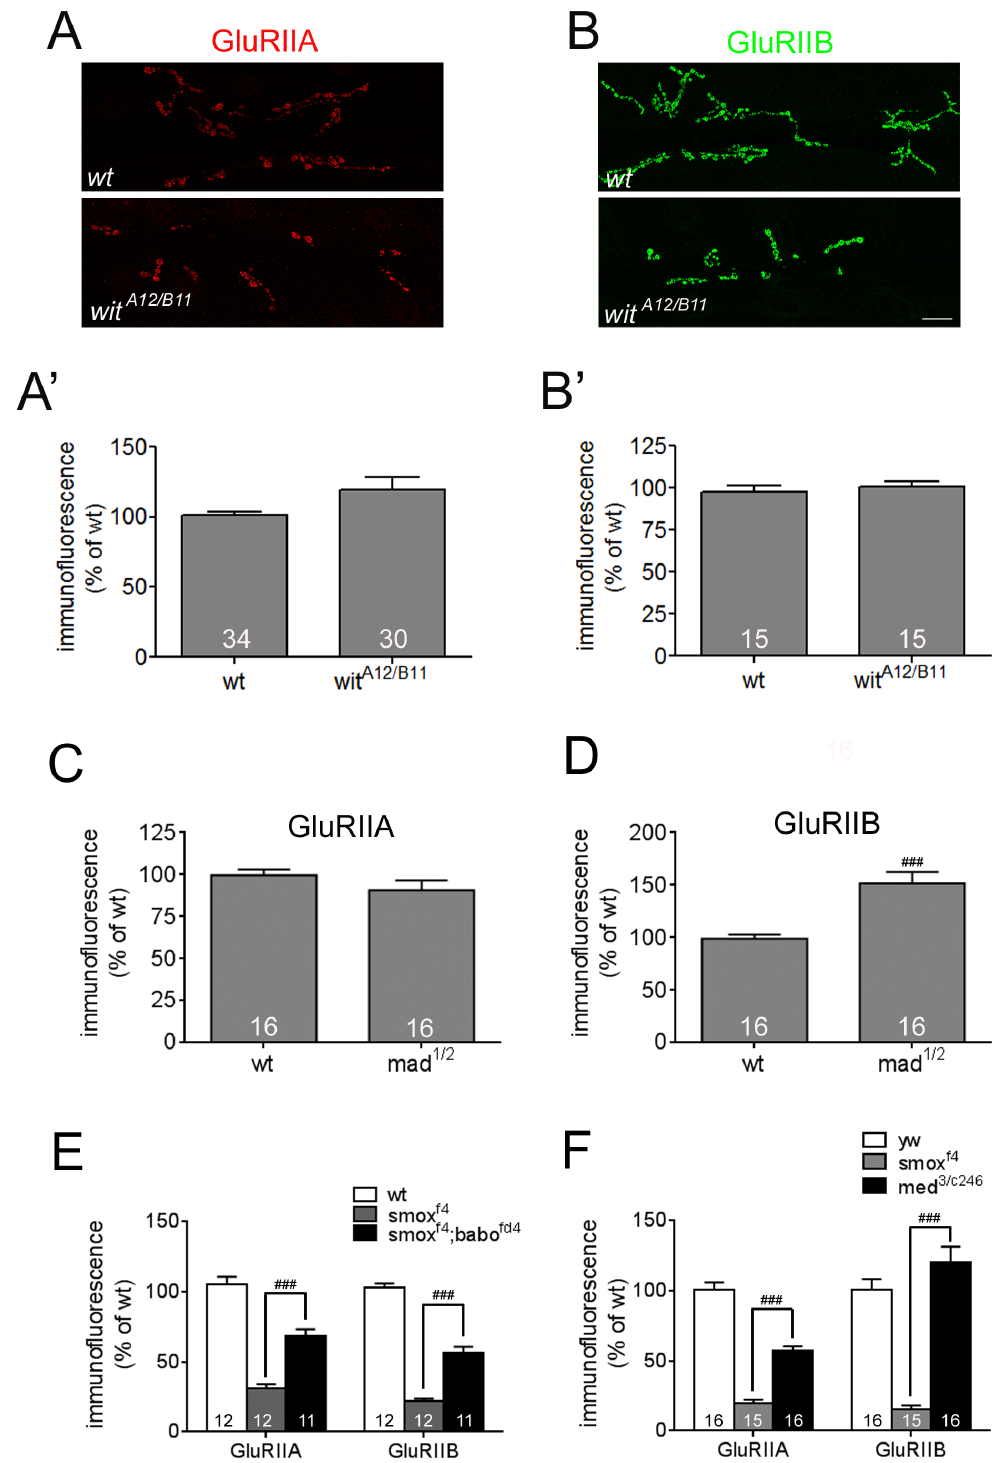
Figure 7. BMP signaling mutants display normal or increased abundance of synaptic GluRs. Representative confocal images of GluRIIA (A) and GluRIIB (B) stainings from wild-type and wit A12/B11 animals. (A 9 and B 9 ) Quantification of GluRIIA (A 9 ) and GluRIIB (B 9 ) densities of wild-type and wit A12/B11 animals. (C and D) Quantification of GluRIIA (C) and GluRIIB (D) densities of wild-type and mad 1/12 animals. (E) Quantification of synaptic GluRIIA and GluRIIB abundances in smox and smox;babo double mutants. Introduction of babo mutation in the smox mutant background increased the GluR levels toward those of the babo mutant. (F) Quantification of synaptic GluRIIA and GluRIIB abundances in smox and med mutants. A mutation in med increased the GluR levels from those of smox mutant. Error bars represent SEM. ### p , 0.001 from unpaired t-test. Scale bar equals 20 m m.